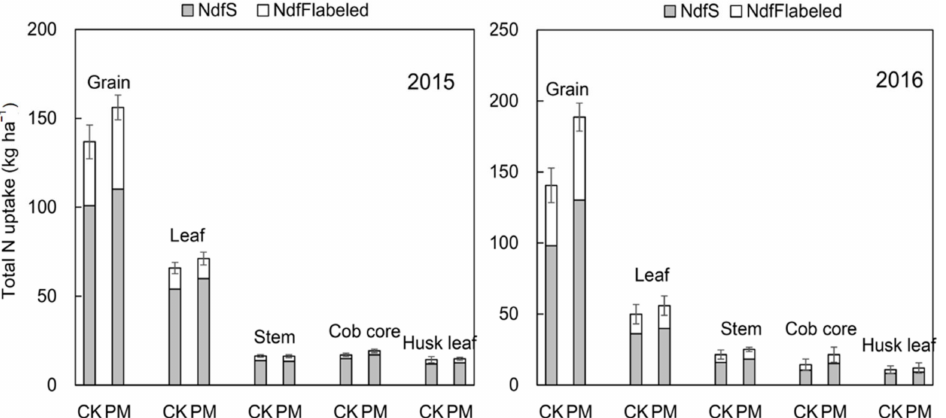
Figure 4. Maize dry matter biomass, total N uptake, N derived from the soil (NdfS) and fertilizer (NdfF labled ), N derived from labeled-urea fertilizer (NdfF labeled ), as affected by plastic mulch at harvest in 2015–2016.